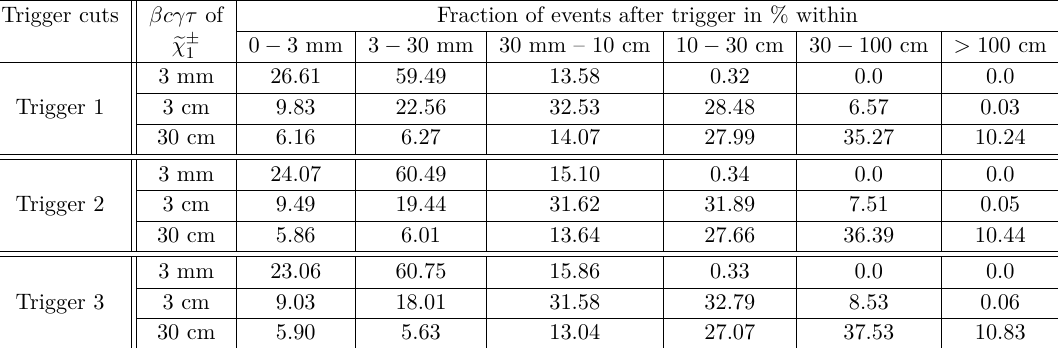
Table 28. After triggering event with p T and η cut, the fraction of charginos which decay in differ- ent regions of tracker (or outside) in detector with decay length of a few mm upto few